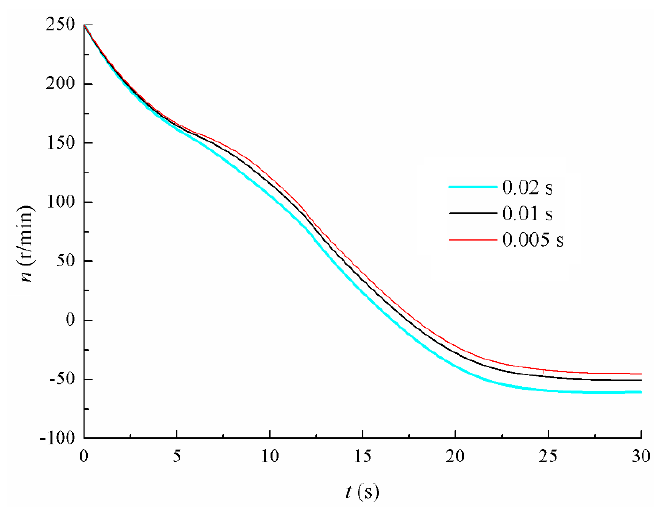
Figure 6. Pre-calculated results of different time step schemes.